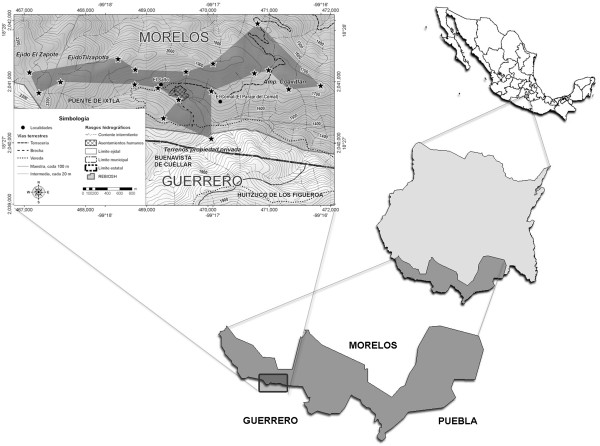
Location and boundaries recognized by the people of El Salto, Puente de Ixtla, Morelos, Mexico.